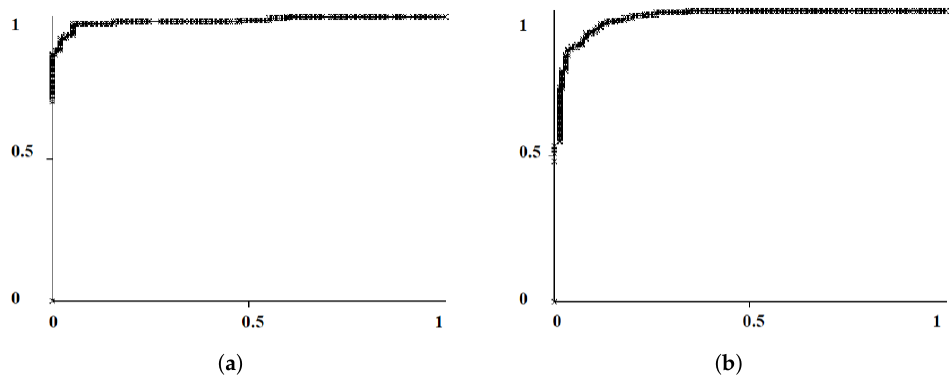
Figure 11. ROC curves for a stack generalization classifier for the OMI-DB digital database: ( a ) 2 features after feature selection (AUC = 0.97); and ( b ) 51 features (AUC =